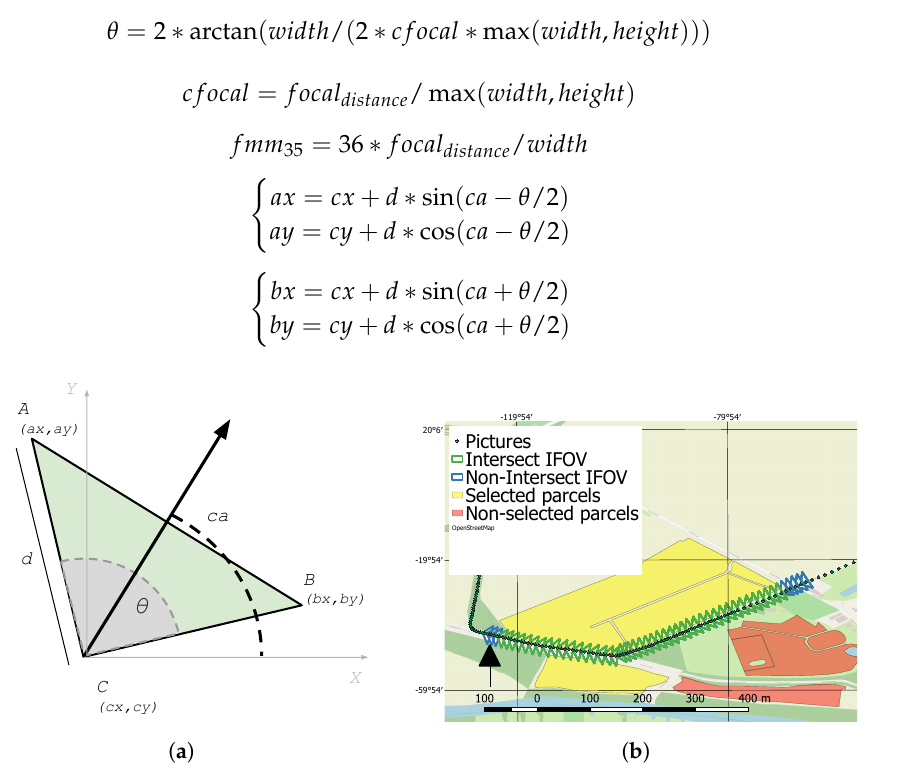
Figure 3. The Instantaneous Field Of View (IFOV, green triangle Figure 3 a from the point where the picture was taken (C) is obtained by calculating the triangle coordinates based on the picture’s metadata. The camera angle (CA) is the moving direction of the sensor. The horizontal angle of view ( θ ) represented in grey is the azimuth field of view of the camera and thus varies according to the sensor. Figure 3 b shows the process of intersecting the generated (in this case triangular) IFOVs with the parcel boundaries, leading to parcel selection (yellow) or not